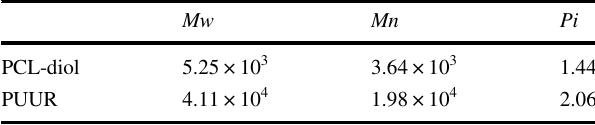
Table 2 Average molecular masses for polymer samples